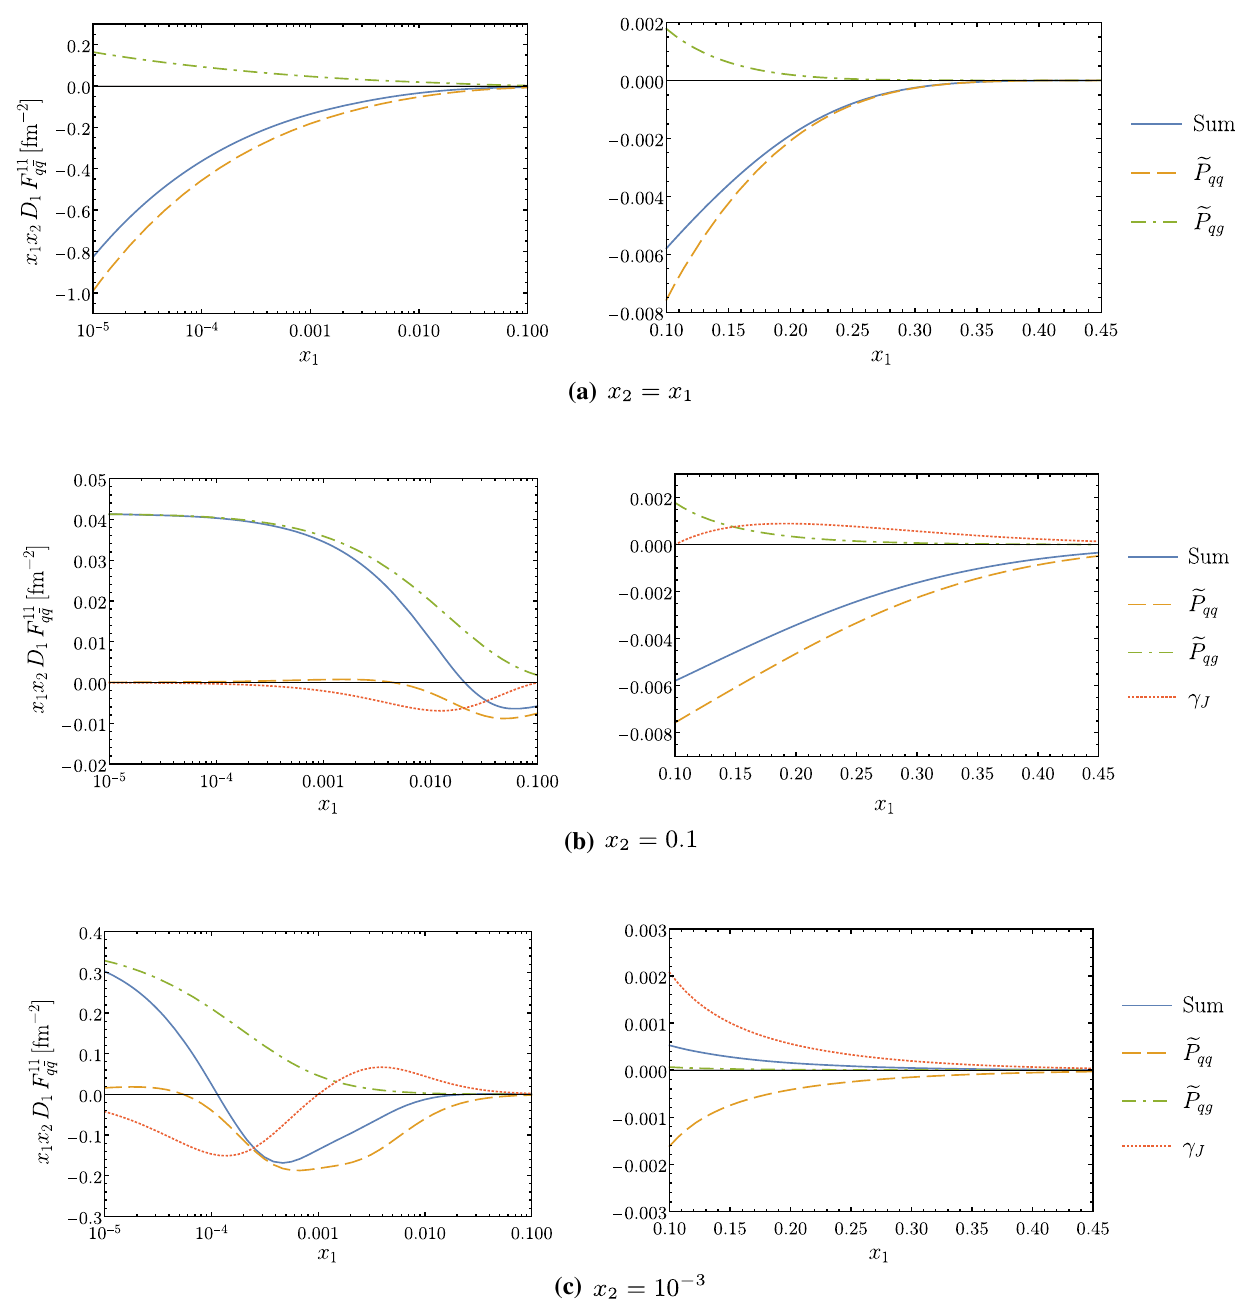
Fig. 4 The right-hand side of (41) with q ¯ q = u ¯ u , evaluated at μ = b 0 / y = 10GeV and ζ p = μ 2 /( x 1 x 2 ) with LO splitting DPDs. The individual terms going with (cid:19) P qq , (cid:19) P qg , and γ J are shown as well. The PDFs used in the splitting formula are specified in the text below (34). A weighting factor x 1 x 2 is included to keep details visible at higher momentum fractions which is natural for the perturbative splitting mechanism [20]. With this choice, the term with ζ p is zero at x 1 = x 2 . At that point, a negative value of (41) must hence be due to the (cid:19) P qq . We see in Fig. 4 that there are regions in x 1 term with